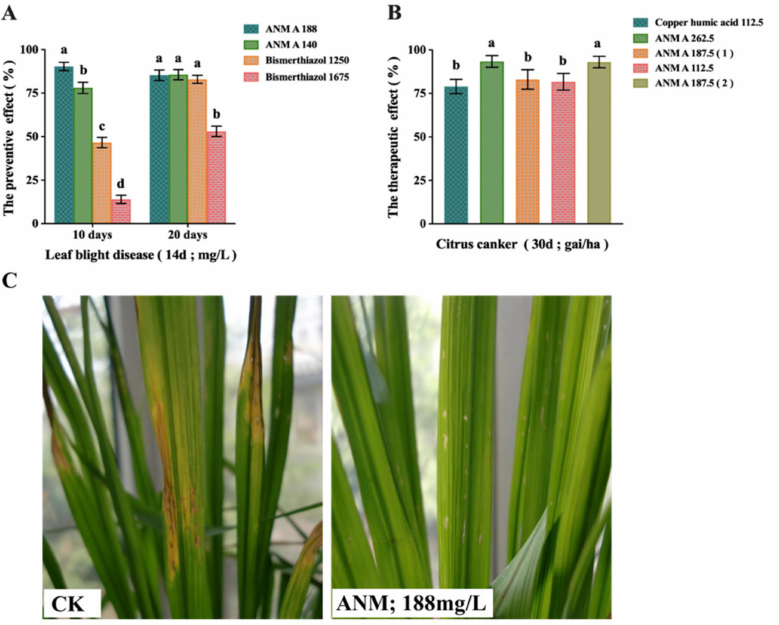
Figure 4. Evaluation of in vivo antibacterial activity of ANM A. ( A ) The cutting leaf method: preven- tive effect of ANM A on rice bacterial leaf blight caused by X. oryzae pv. oryzae ; ( B ) therapeutic effect of ANM A on citrus canker caused by X.citri. ( C ) The piercing leaf method: preventive effect of ANM A on rice bacterial leaf blight caused by X. oryzae pv. oryzae . The data are shown as means ± SD of three independent experiments. Lowercase letters indicate significant differences ( p < 0.05) between any two